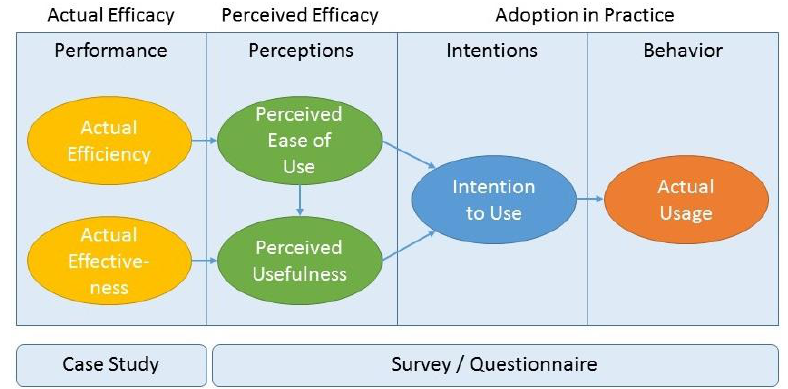
Figure 1. Method Evaluation Model adopted from [25]